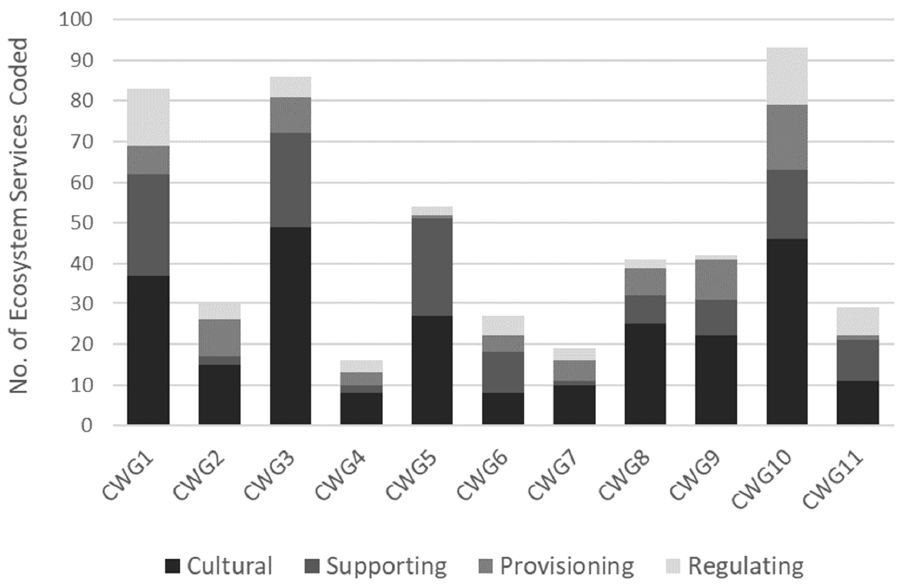
Figure 1. Count of Ecosystem Services Referenced by CWGs.